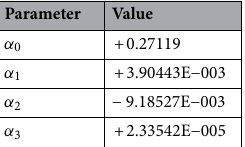
Table 6. The coefficients of proposed correlation by